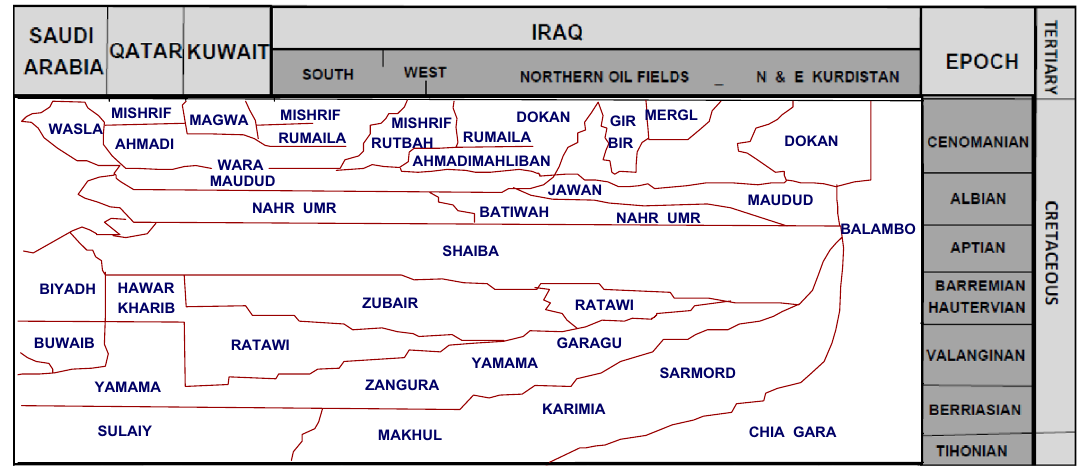
Figure 2. Equivalents to Yamama Formation in Iraq and the neighboring Arab countries modified from 8 by using Didger 3